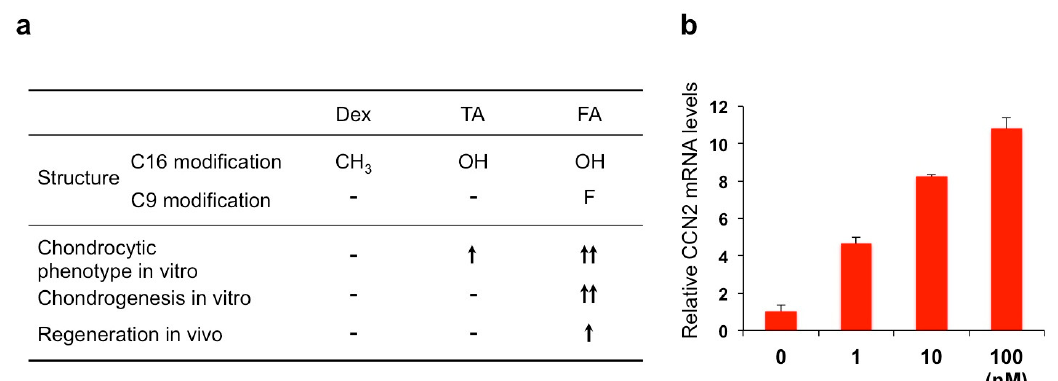
Figure 7. ( a ) Structural–functional relationship of three glucocorticoids. TA, triamcinolone acetonide; FA, fluocinolone acetonide. ( b ) Induction of CCN2 in ATDC5 chondrogenic cells by FA. ATDC5 cells in monolayer culture were treated with different concentrations (1–100 nM: horizontal axis) of FA for 24 h, and analyzed for expression levels of CCN2 mRNA.